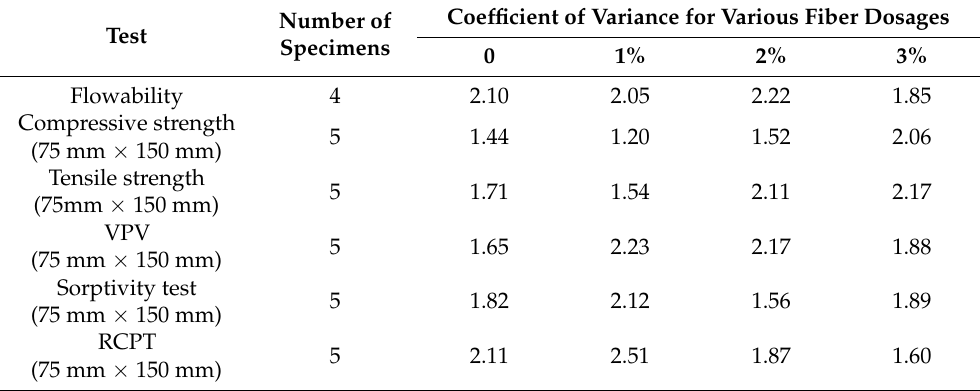
Table 3. Coefficient of variance of different tests conducted.